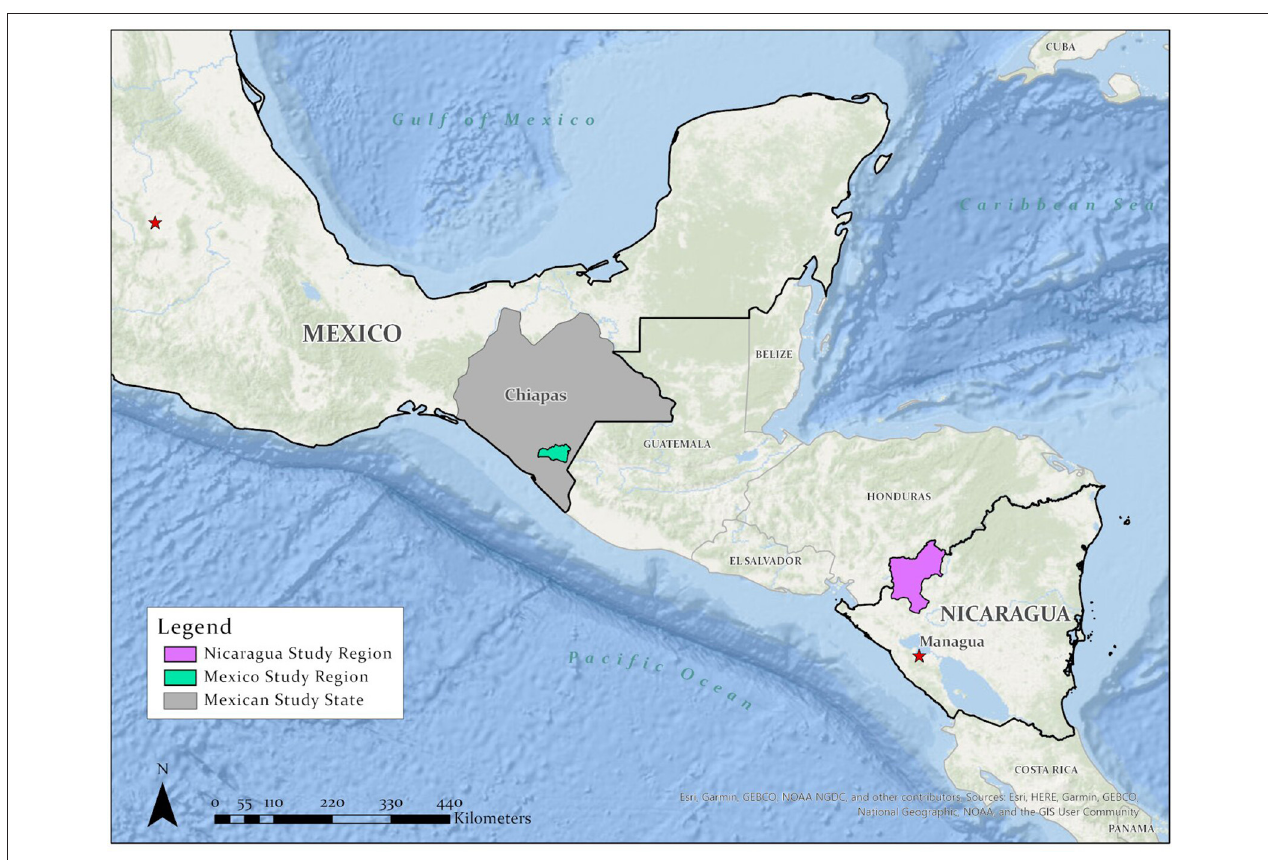
FIGURE 1 | Location of CESMACH (Mexico) and PRODECOOP (Nicaragua). Created by Emma McCurry, Santa Clara University.